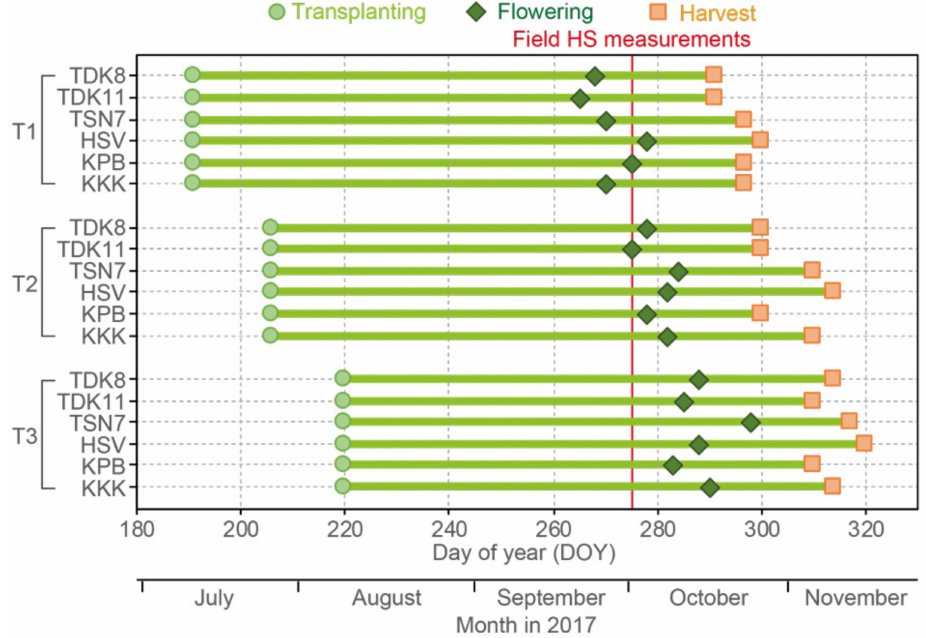
Figure 2. Transplanting, flowering, and harvest dates of rice for each single plot in the experimental